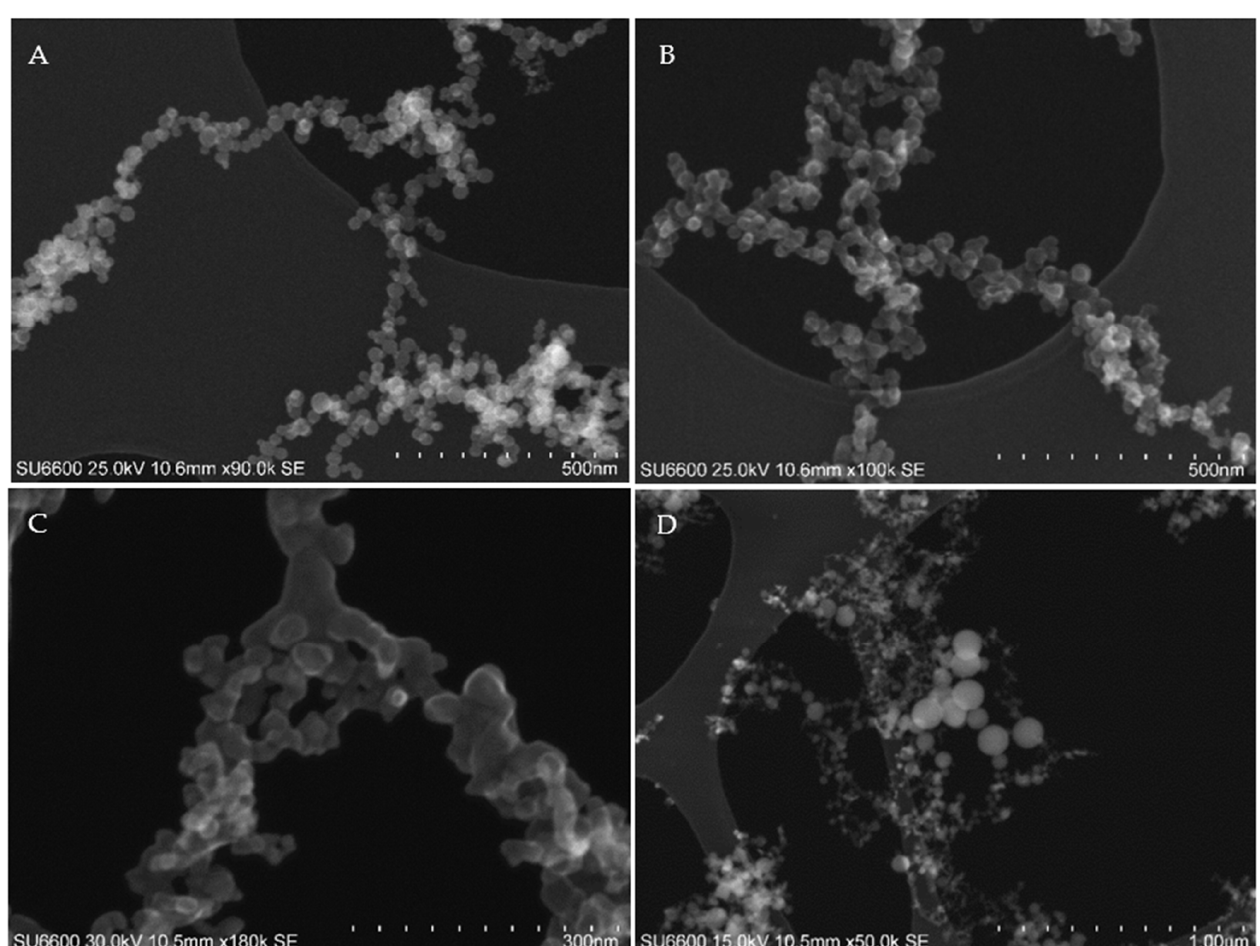
Figure 3. Secondary electron images of: ( A ) agglomerate of spherical primary particles, ( B ) agglomerate/aggregate of primary particles, ( C ) magnification of an aggregate, and ( D ) larger condensation particles.